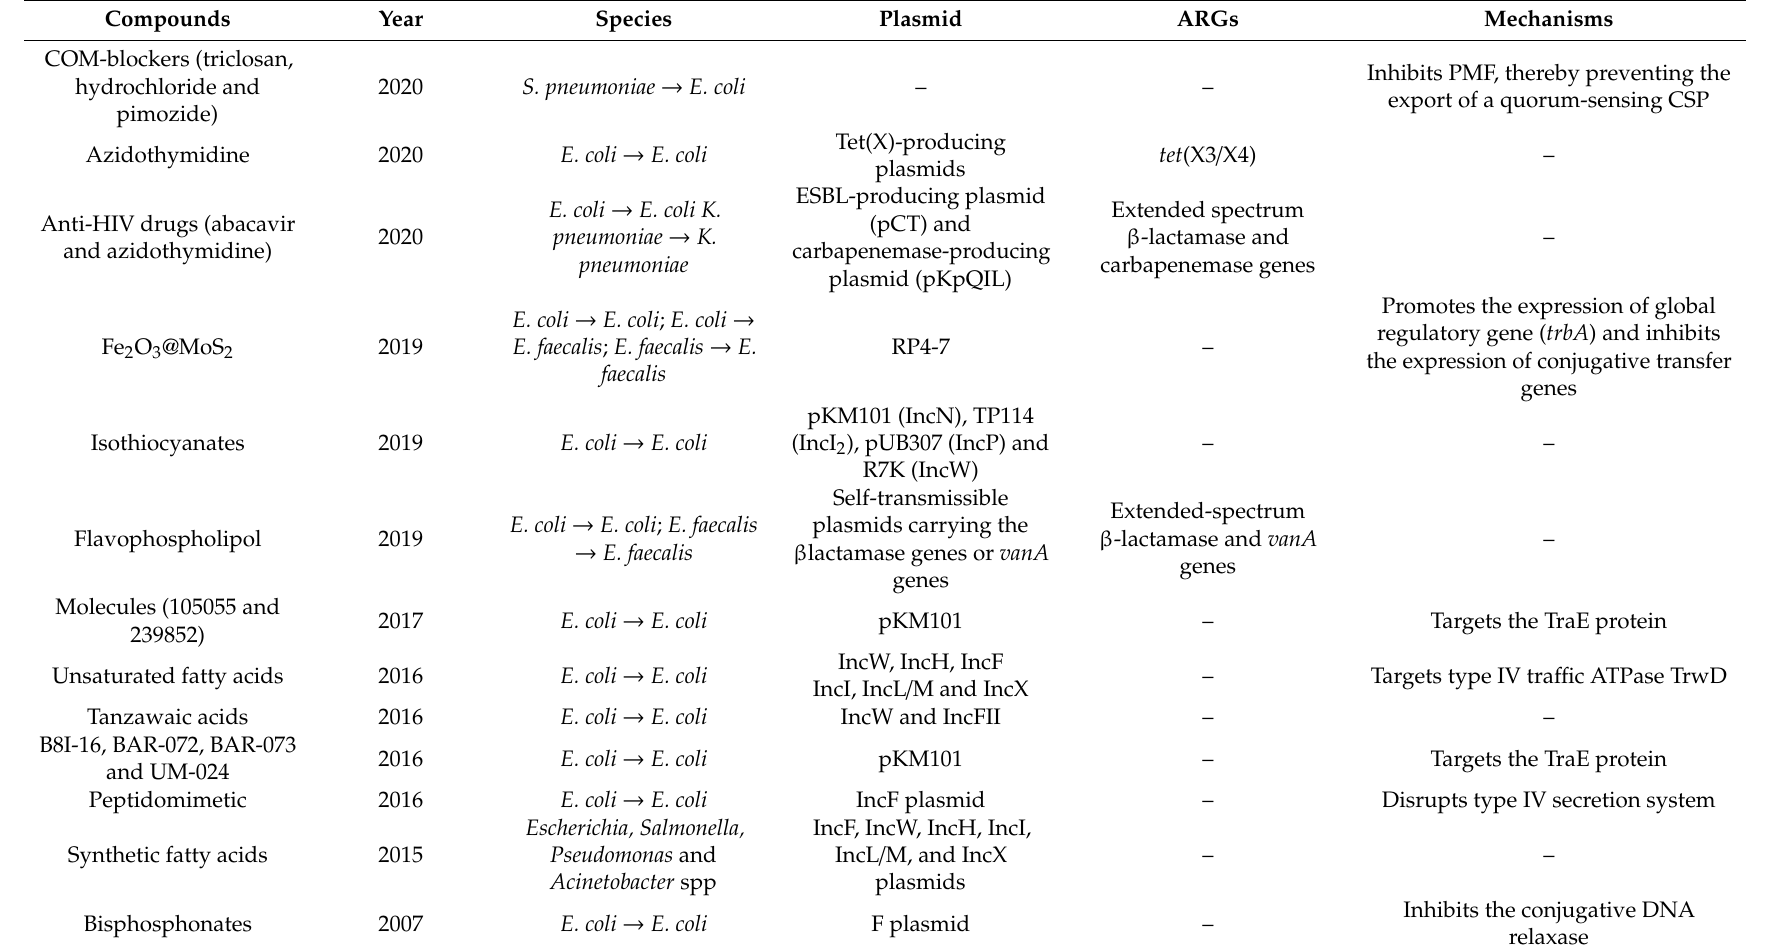
Table 2. Exogenous compounds that inhibit horizontal transfer of antibiotic resistance genes